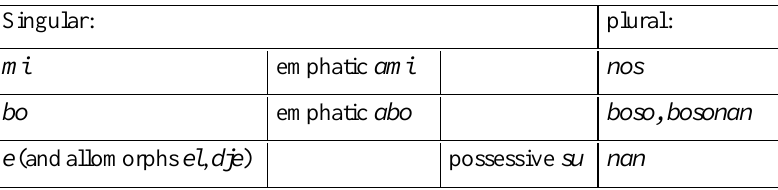
Table 1. Papiamentu pronouns, according to existing descriptions (e.g.,